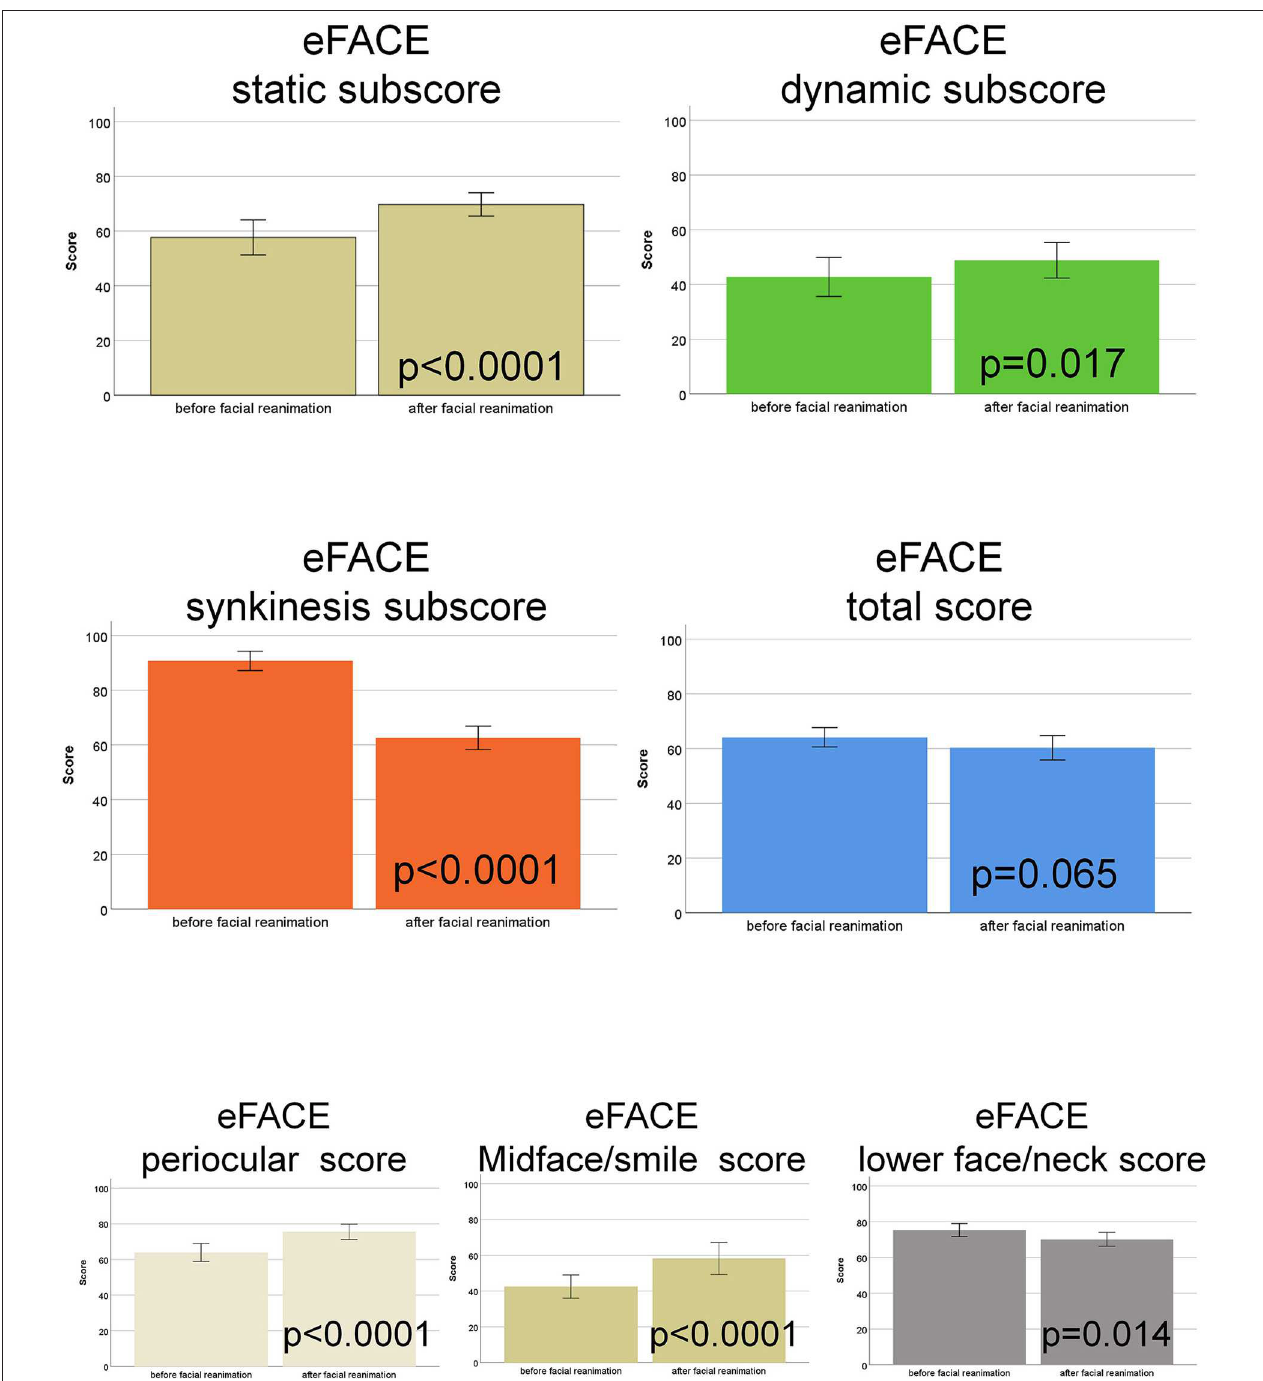
FIGURE 2 | eFACE grading. Comparison of the scores before vs. after hypoglossal-facial jump nerve suture. The four subscores (static, dynamic, synkinesis, total score) and the three zonal scorers (periocular, midface/smile, lower face/neck) are shown in different colors.